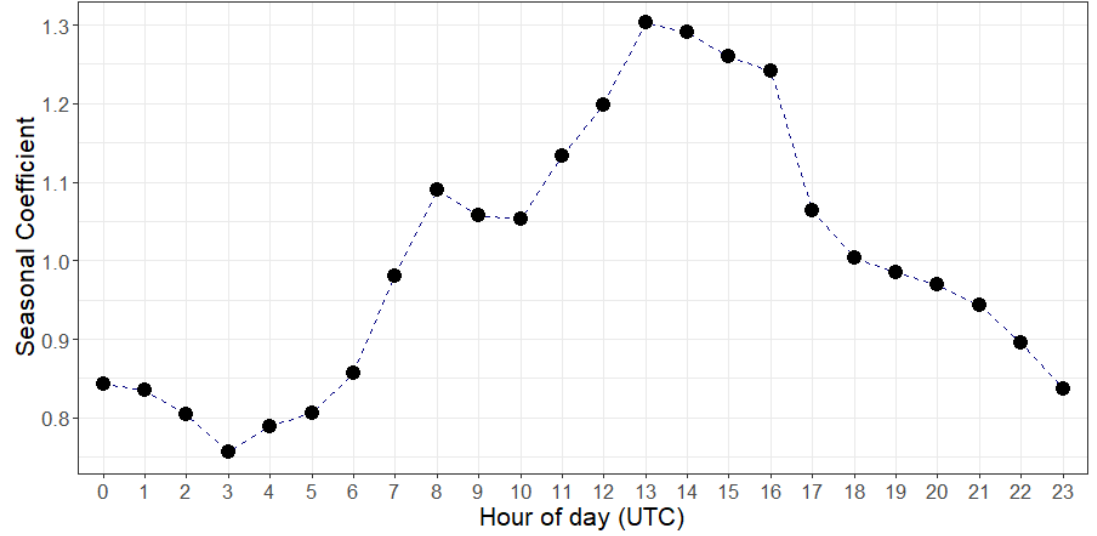
Fig. 6. Multiplicative seasonal coefficients for the hourly volume at different trading